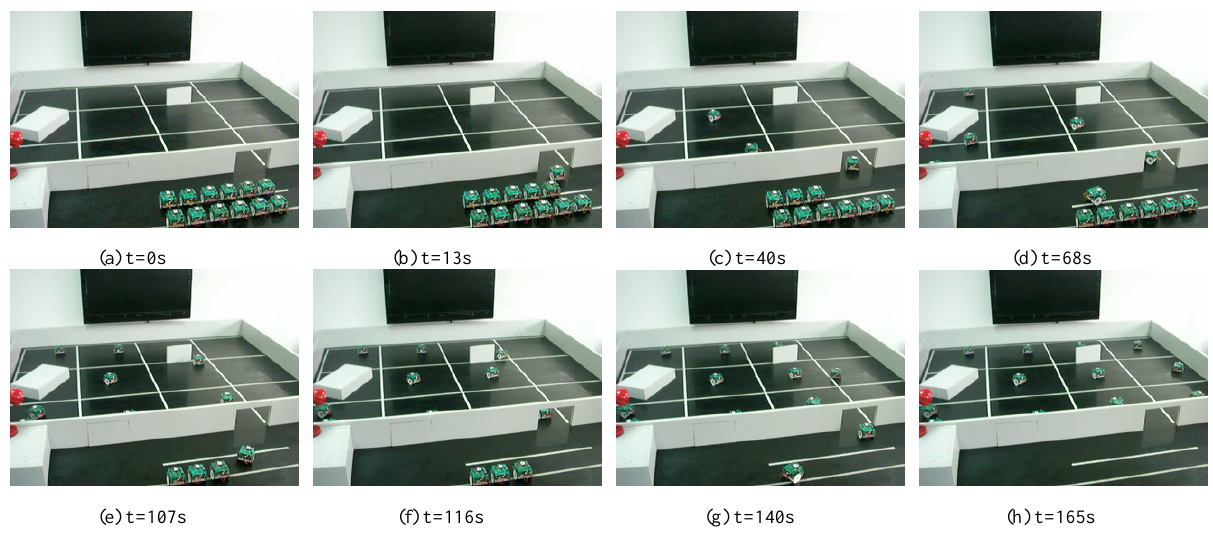
Figure 17. Deployment of a group of twelve mobile sensor